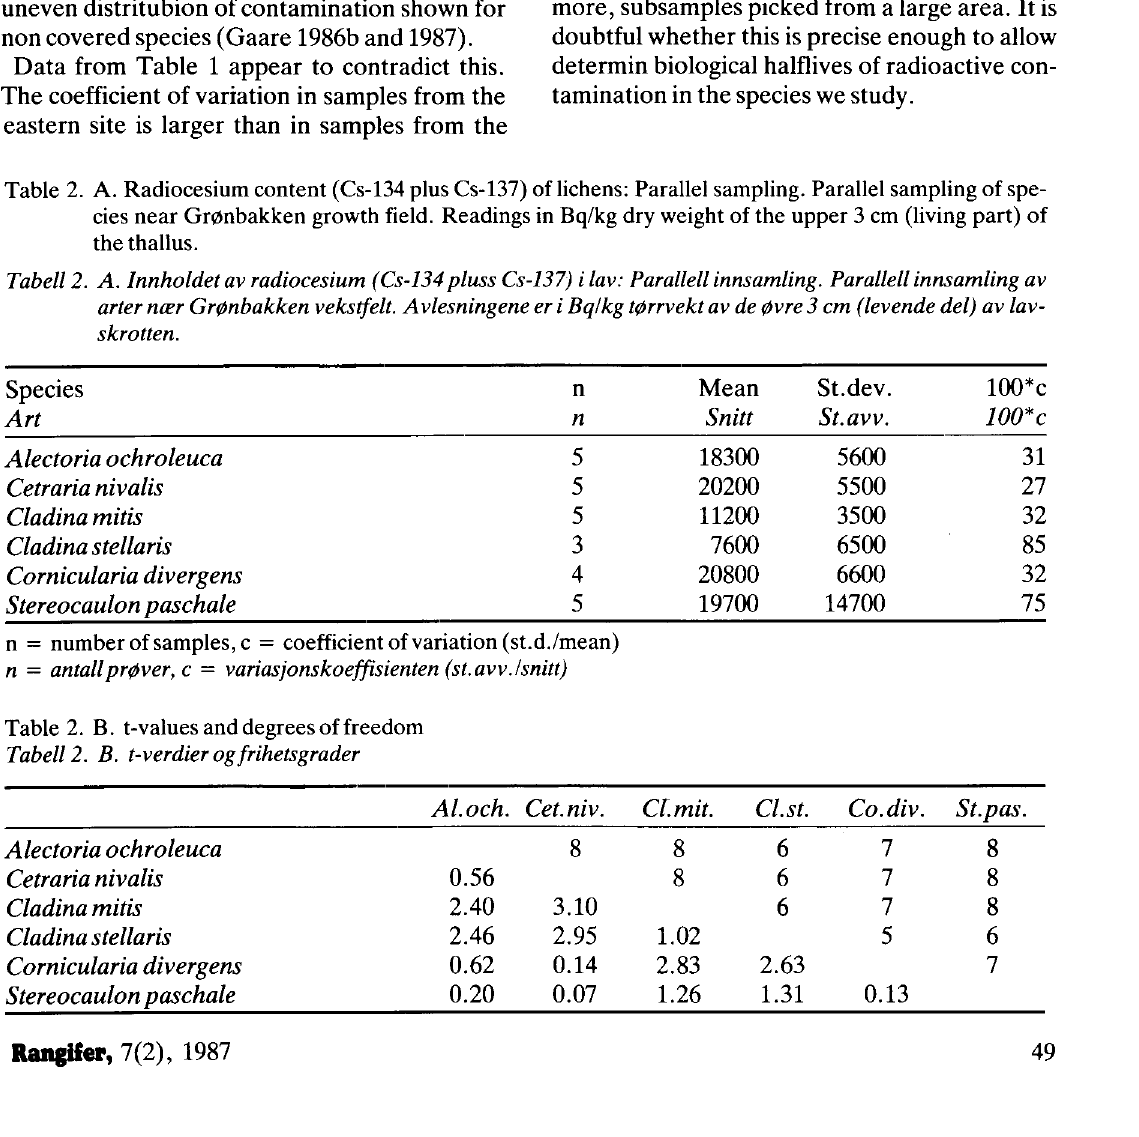
Table 2. B. t-values and degrees of freedom Tabell 2. B. t-verdier og